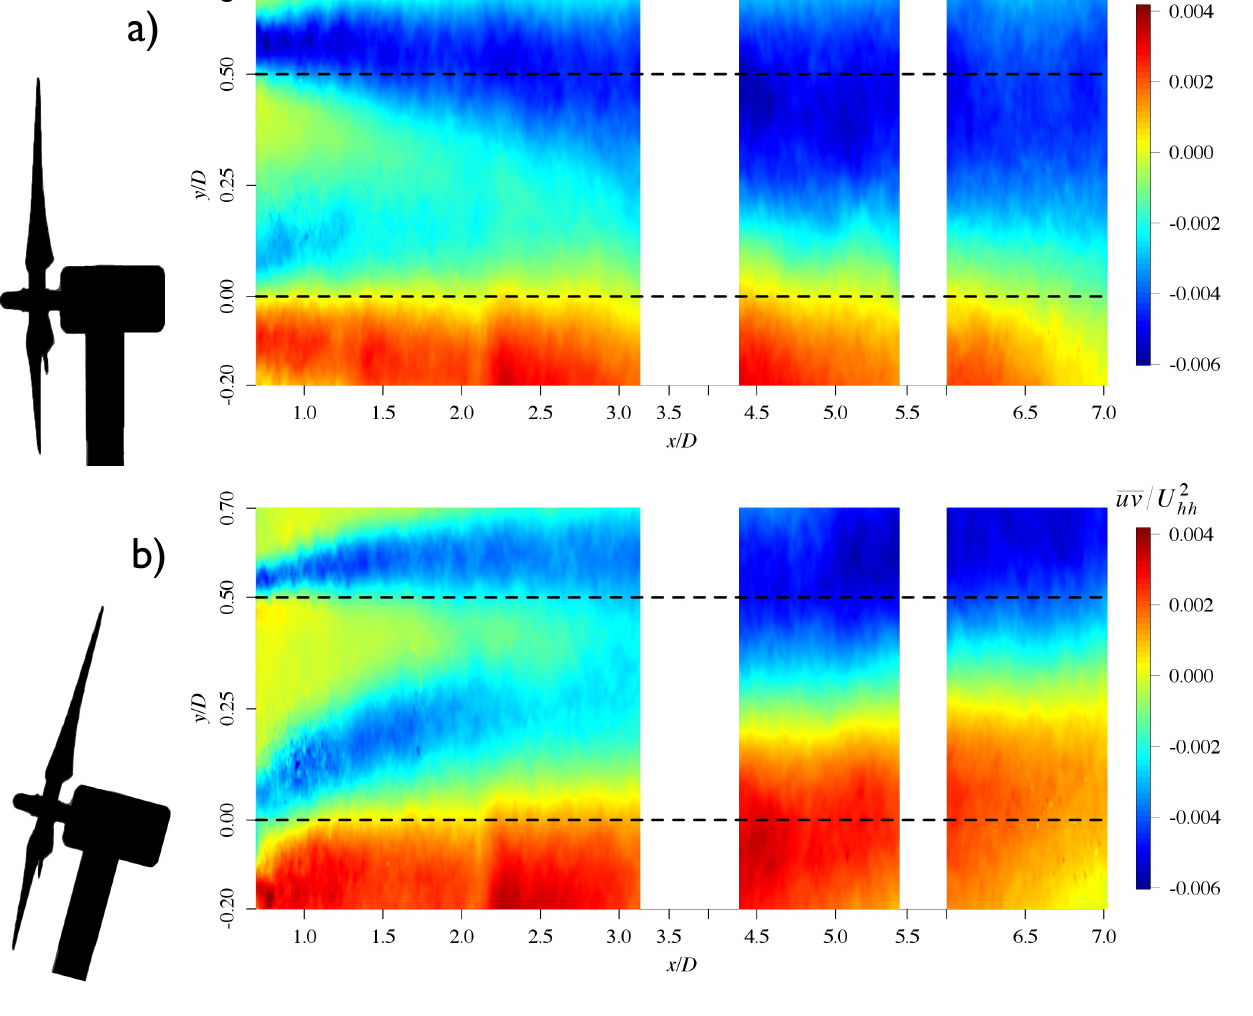
for the fixed and floating cases. Hub hh